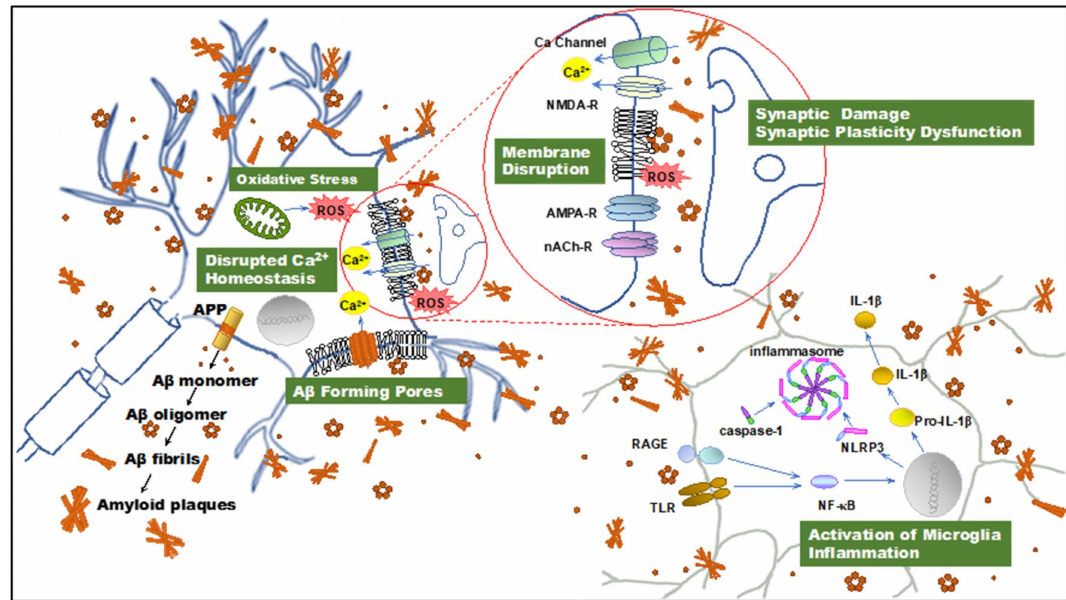
Figure 1. Illustration summarizing amyloid β -protein (A β ) neurotoxicity. A β aggregates induce disruption of cellular homeostasis, which may be the result of inducing or exacerbating membrane disruption, oxidative stress, calcium dysregulation, synaptic plasticity dysfunction, and inflammation. APP: amyloid precursor protein; A β : amyloid β -protein; ROS: reactive oxygen species; NMDAR, N -methyl- d -aspartate receptor. AMPAR, α -amino-3-hydroxy-5-methyl-4-isoxazolepropionic acid receptor; nAChR, nicotinic acetylcholine receptor; TLR: toll-like receptor; RAGE: receptor for advanced glycation endproducts; NF- κ B, nuclear factor κ B; NLRP3: NOD-, LRR- and pyrin domain-containing protein 3; IL-1 β : interleukin-1 β